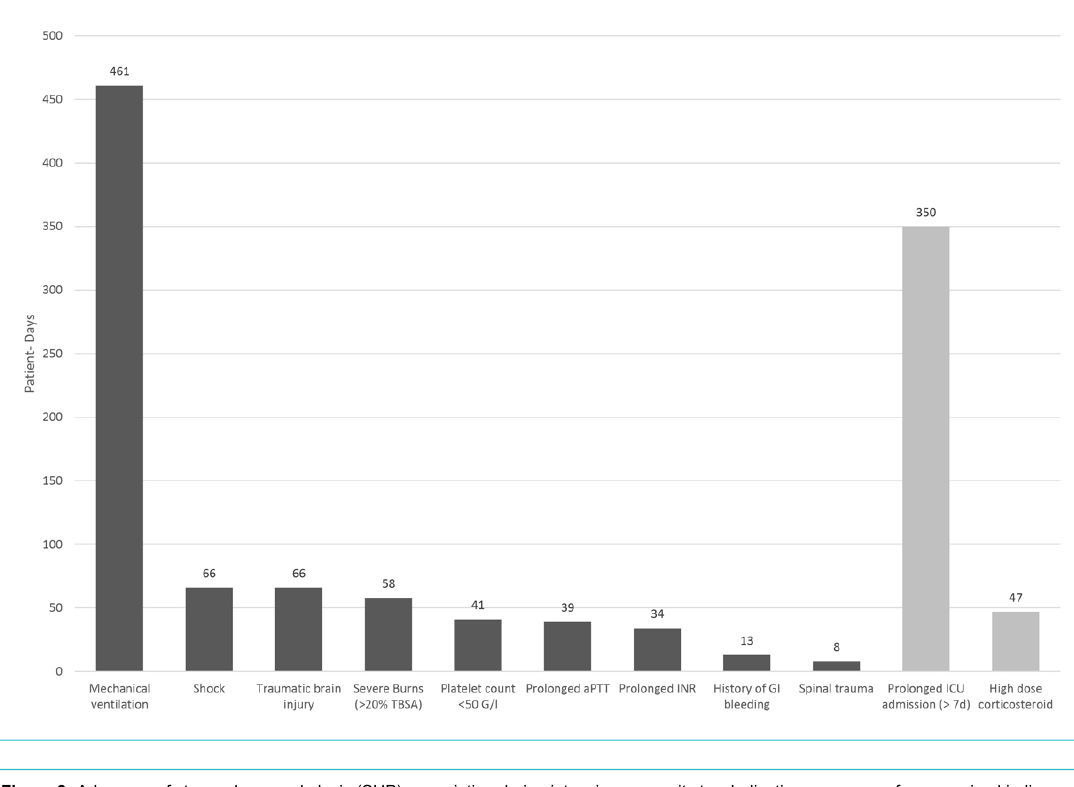
Figure 3: Adequacy of stress ulcer prophylaxis (SUP) prescription during intensive care unit stay. Indication: presence of a recognised indica- tion according to our local